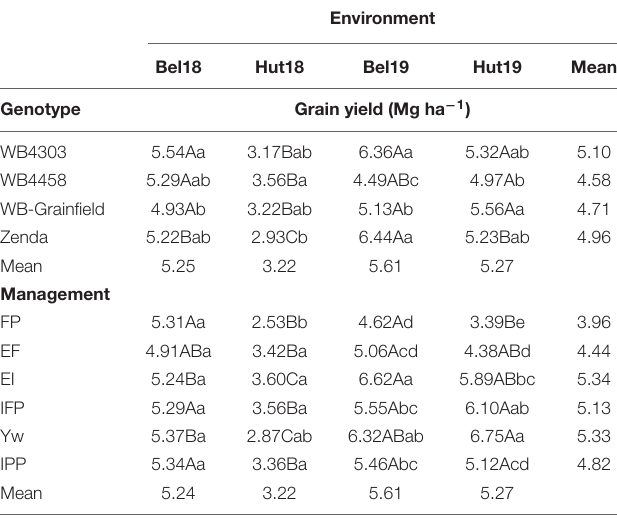
Each stepwise increase in management intensity modulated different yield components ( Figure 6 ). In the first step (i.e., addition of enhanced fertility to the FP), the responsiveness of yield ranged from 0.85 to 2.22 (mean: 1.23 ± 0.03) and